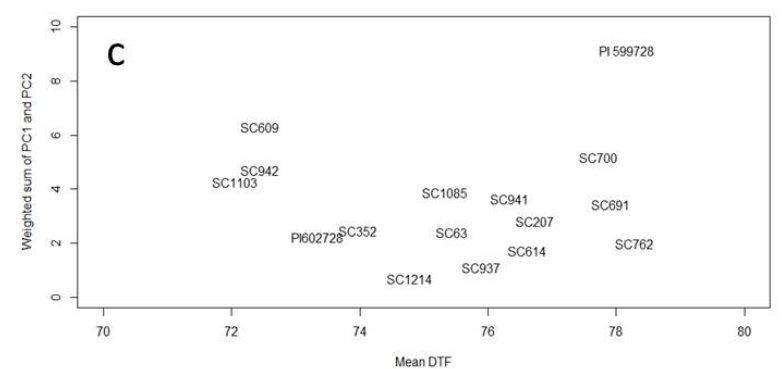
Figure 3. Mean values and stability, depicted as weighted sum of PC1 and PC2, of the top 5% ( n = 19) ( a ) performing genotypes for field emergence; ( b ) juvenile shoot dry weight (SDW); and ( c ) days to flowering (DTF).